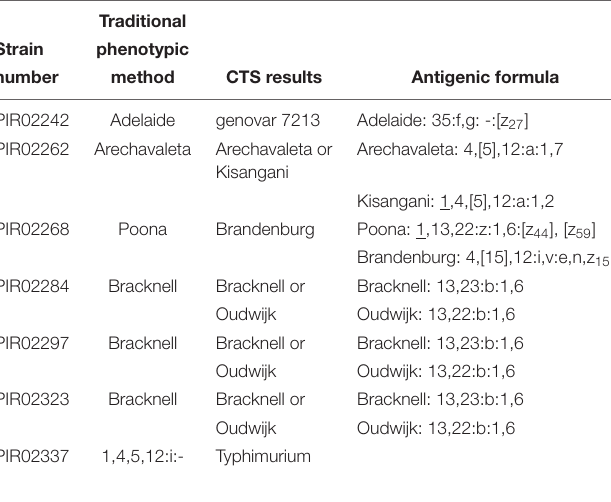
TABLE 3 | Check and trace Salmonella assay discrepant results.